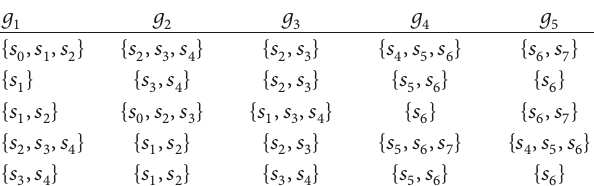
Table 2: Expert information matrix 𝐻 (2) [15]. Table 3: Expert information matrix 𝐻 (3)